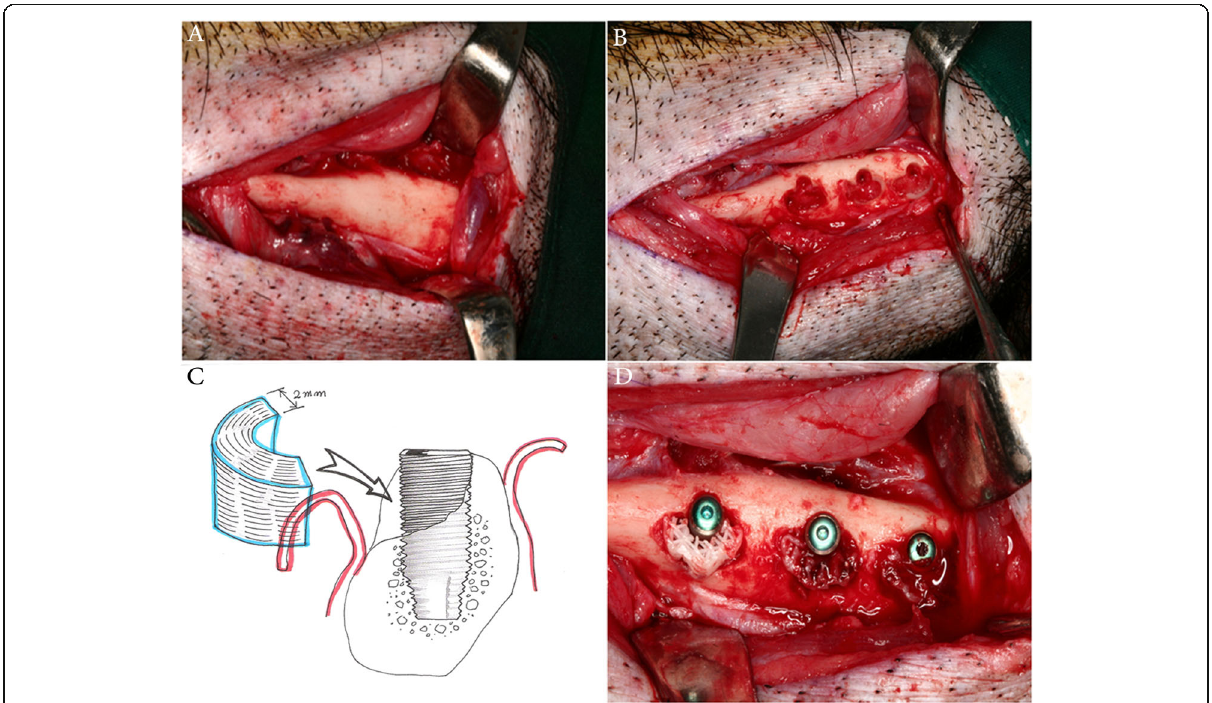
Fig. 2 Intraoperative photographs showing the implants site drilling and placement of the MSCs-PRP-loaded PCL-TCP scaffolds. a Incision was made along the inferior border of the mandible bilaterally within the premolar area. b Three implant sites were drilled with buccal half circle bony defects. c , d The implants were placed and the scaffolds were placed to cover